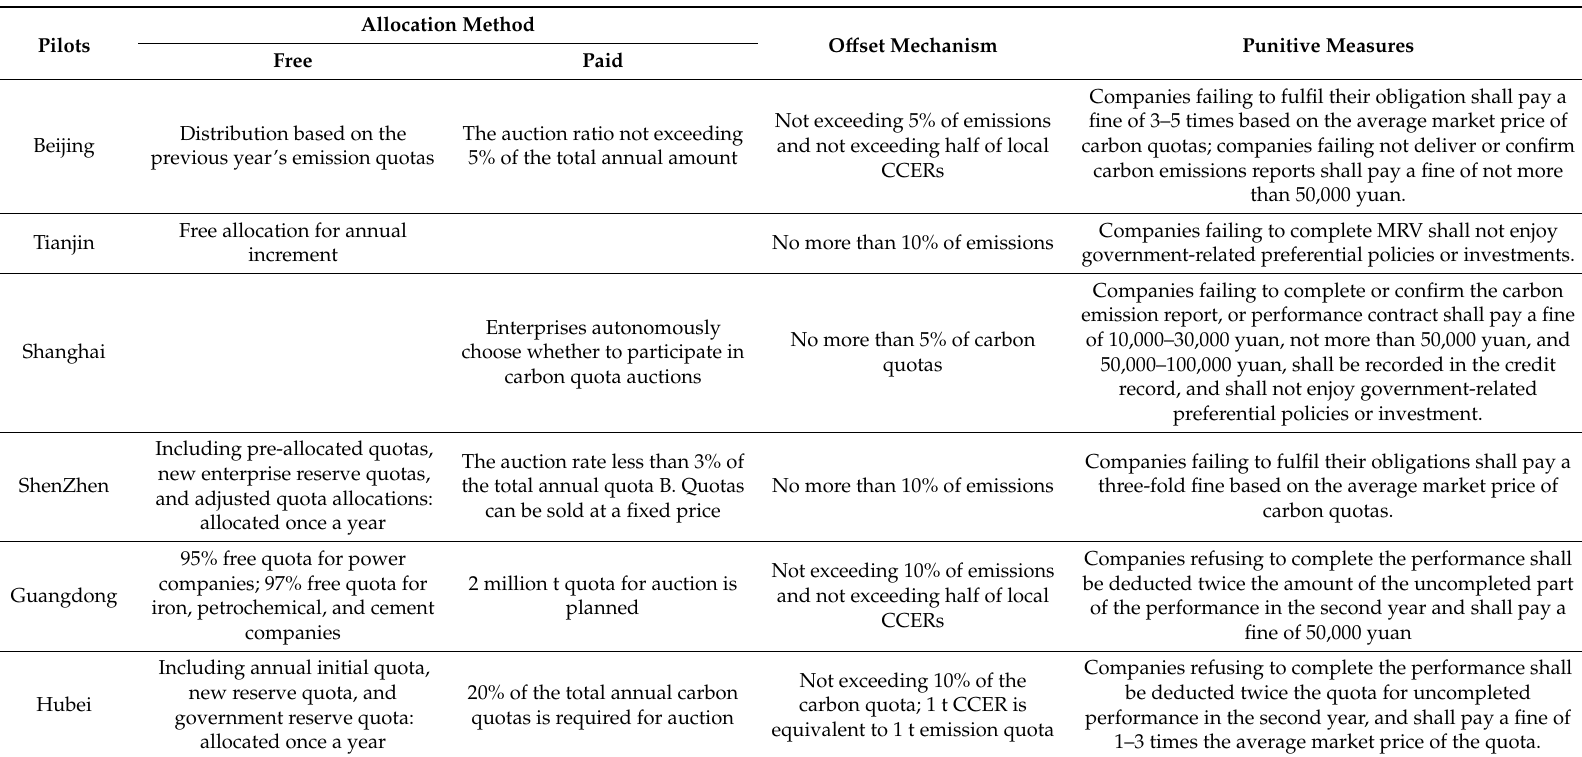
Table 2. Comparison of quota allocation, o ff set mechanism, restriction measure among Chinese ETS pilots, EU ETS, and CA